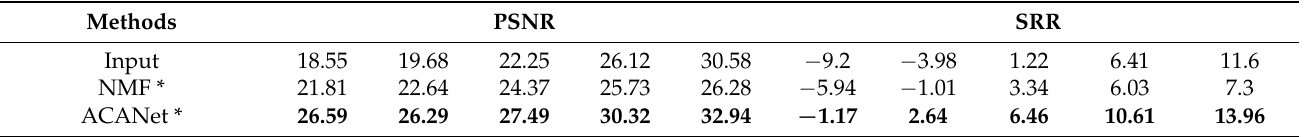
Table 5. Evaluation results of input signals with five different PSNRs and SRRs.